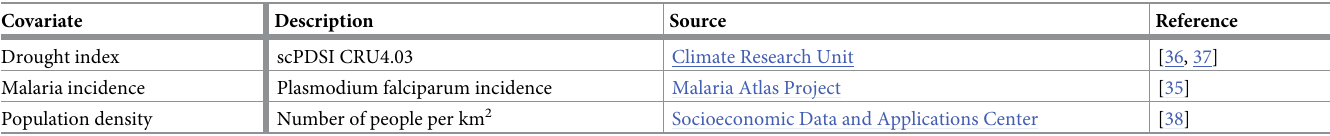
Table 2. Source of remote sensed